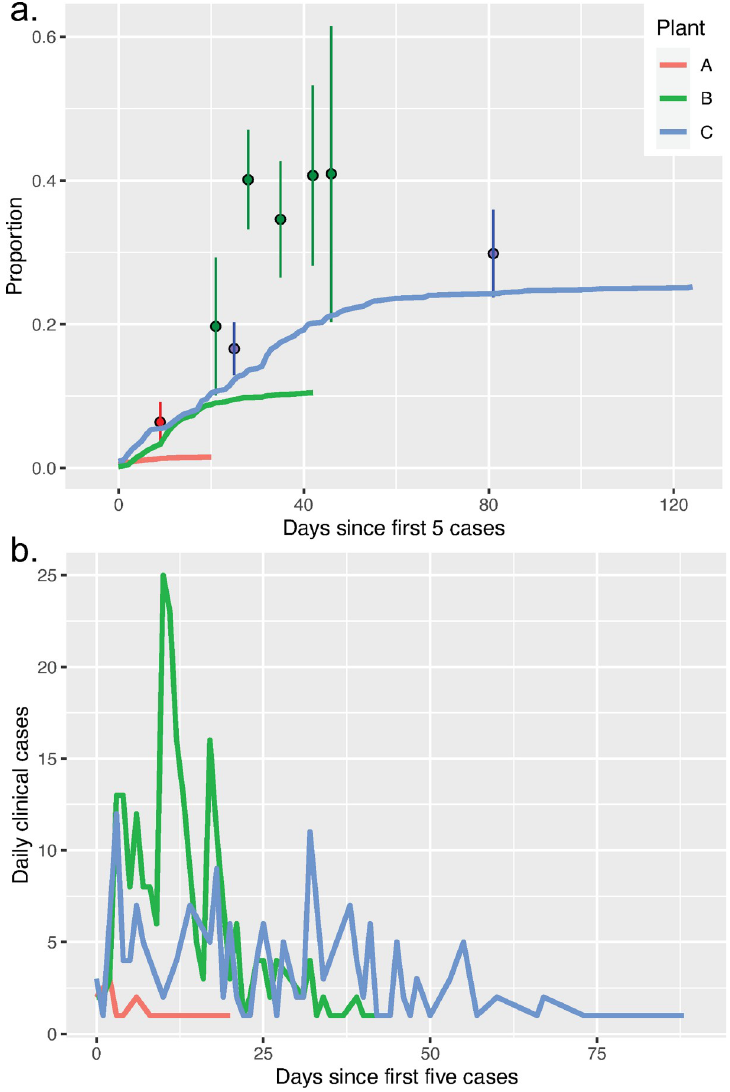
Fig 2. Observed epidemiological dynamics at slaughter plants. a) Cumulative clinical cases (at-home sick, confirmed PCR-positive) as a proportion of the worker population (lines) and proportion positive in company-initiated antibody testing (circles). b) Daily incidence of clinical